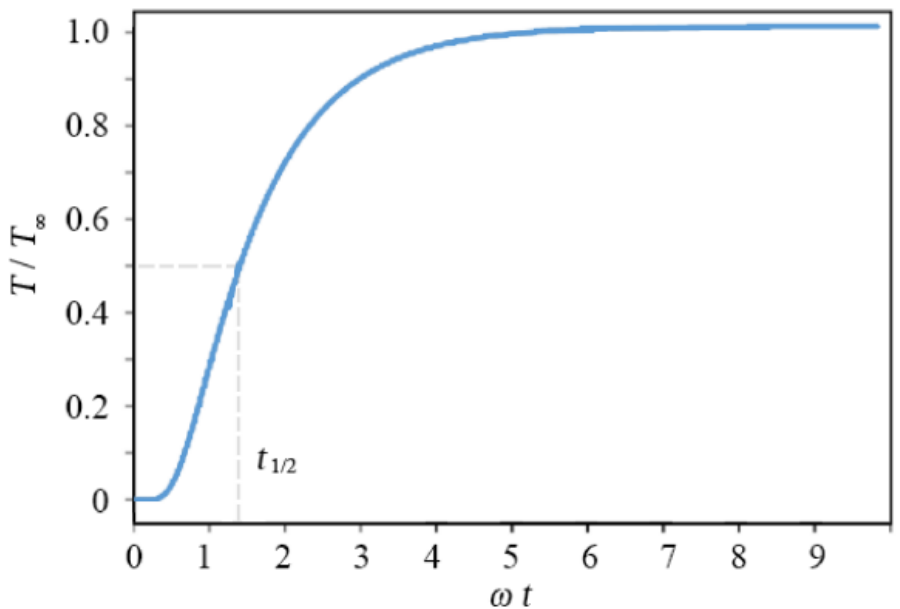
Figure 6. Temperature variation at the back surfaces for a single-layer sample.